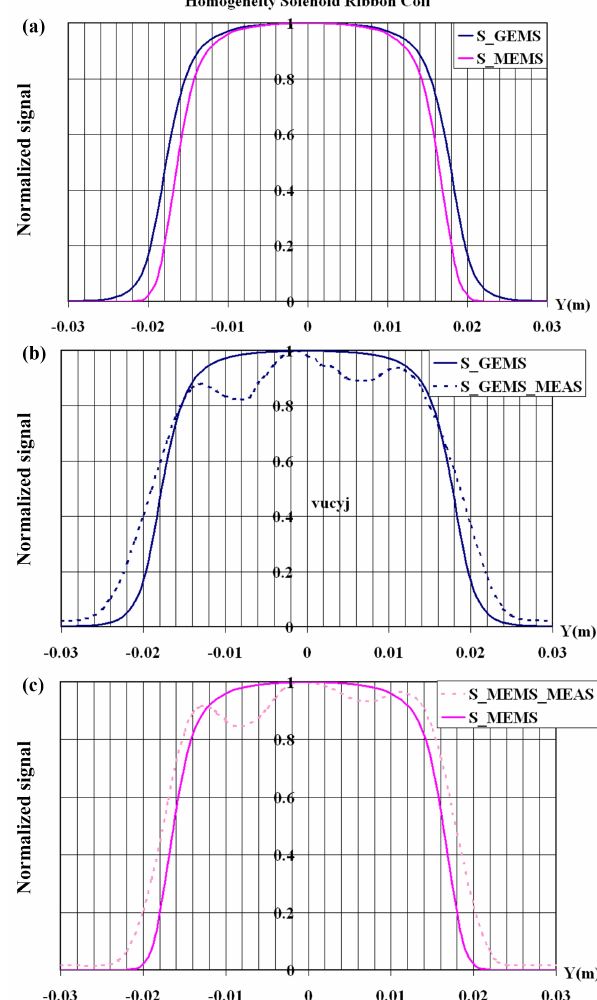
Figure 10. Normalized induced signal comparisons: (a) gra- dient echo sequence (GEMS) versus spin echo sequence (MEMS); (b) gradient echo sequence measured (GEMS– MEAS) versus model (GEMS) (TR = 688ms; TE = 4.5ms; FOV = 10mm × 10mm; 80 slices; thickness = 1mm; resolu- tion = 128 × 128); (c) spin echo sequence measured (MEMS– MEAS) versus model (MEMS) (TR = 10s; TE = 10ms; FOV = 10mm × 10mm; 80 slices; thickness = 1mm; resolu- tion = 128 ×